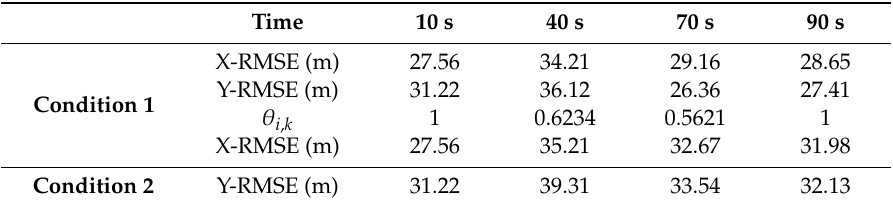
Figure 9. Comparison of position RMSE in adaptive gain correction experiment. Table 3. The effect of adaptive gain correction on target tracking accuracy.